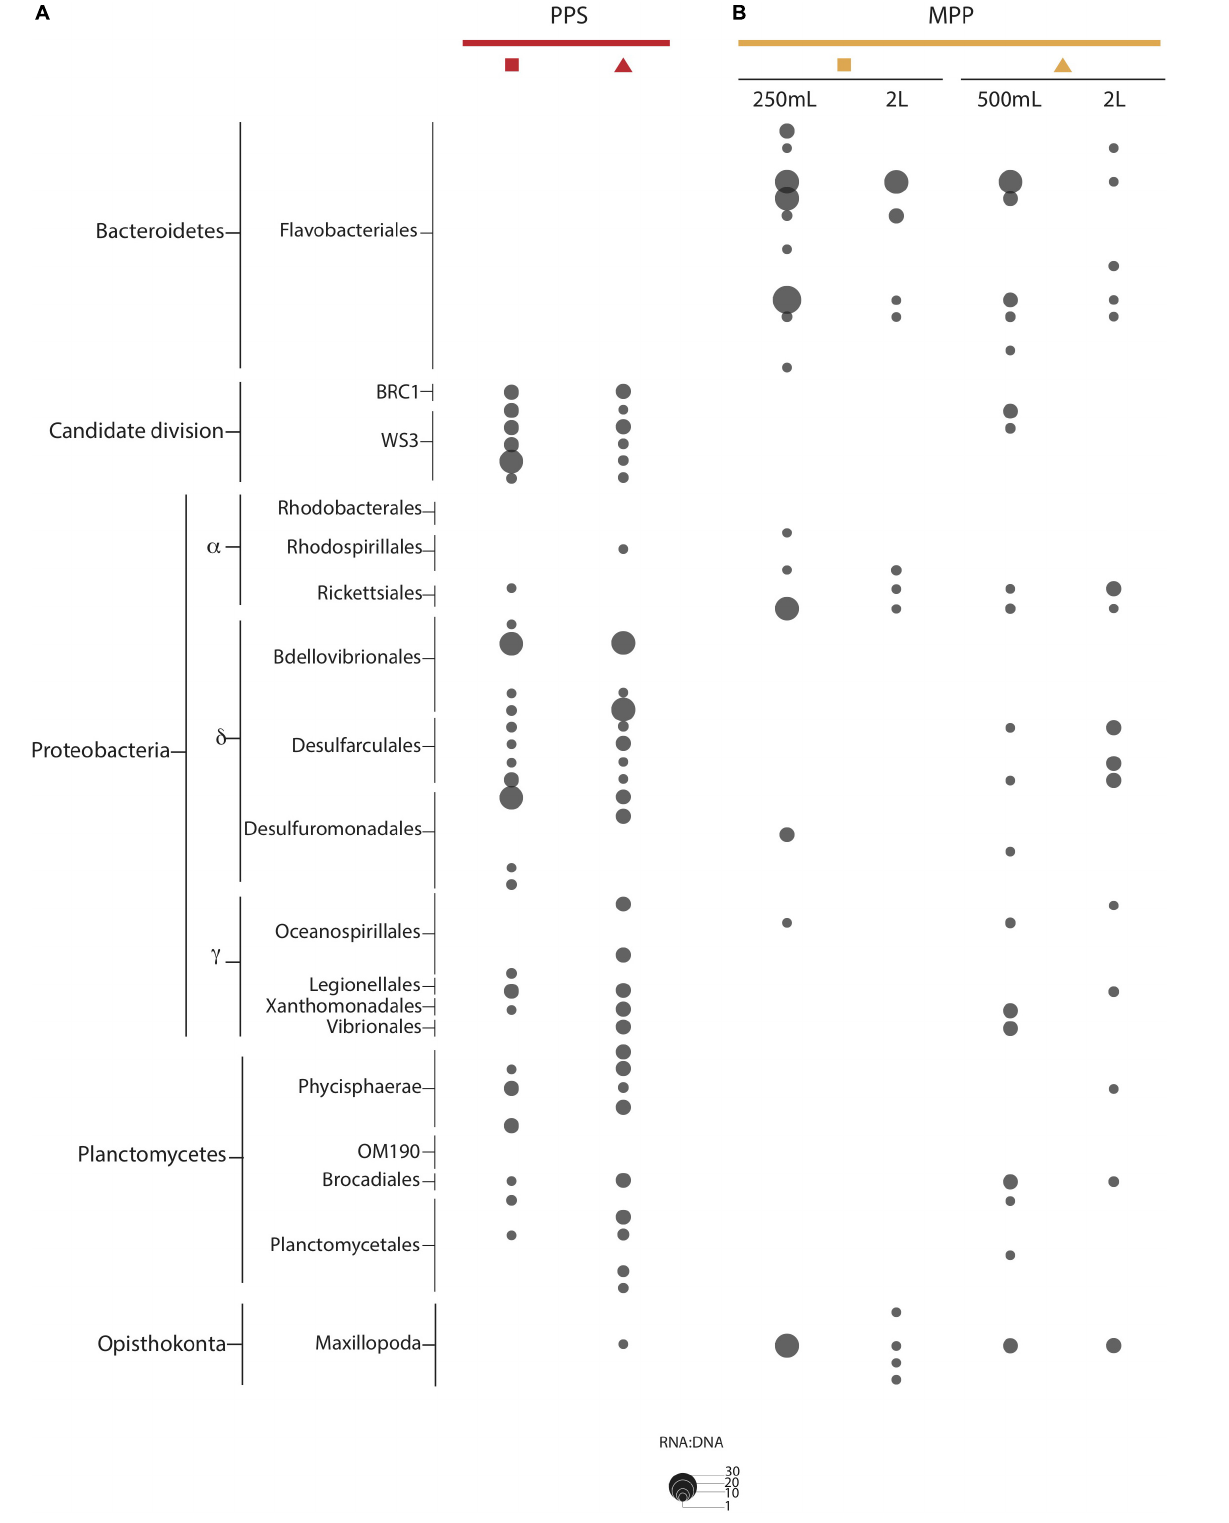
Frontiers in Marine Science |